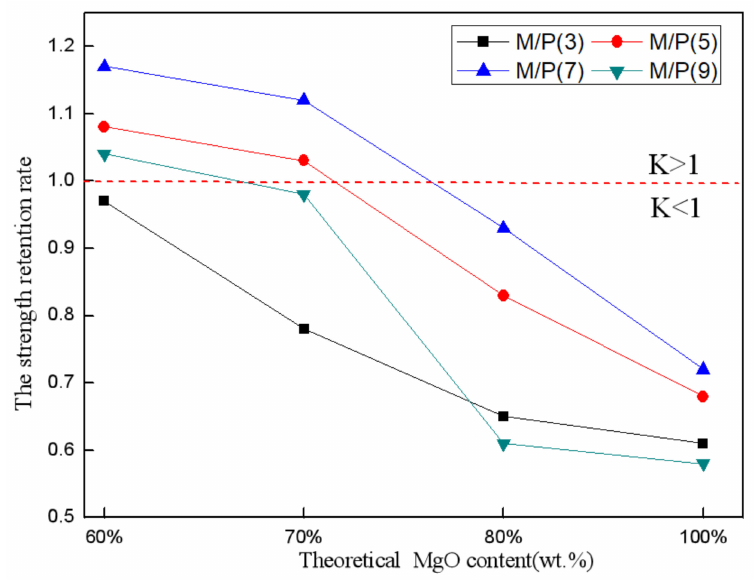
Figure 13. Water resistance of the